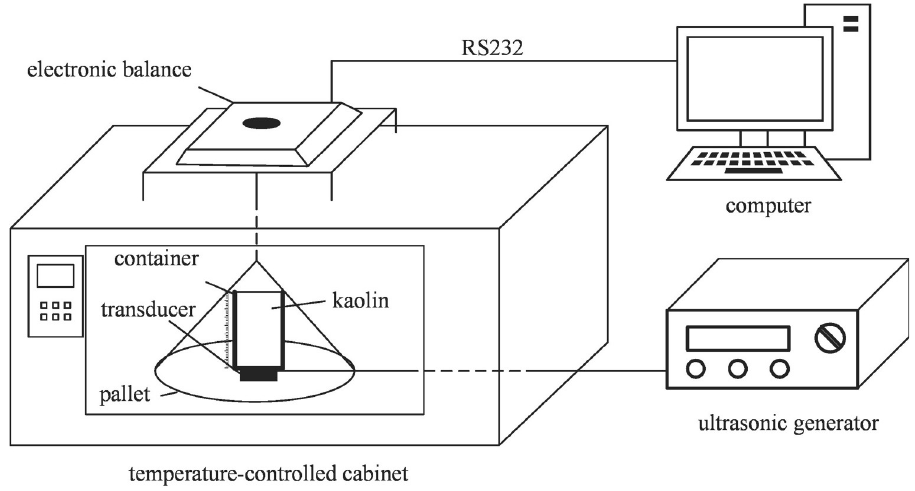
Fig 3. Schematic of the experimental